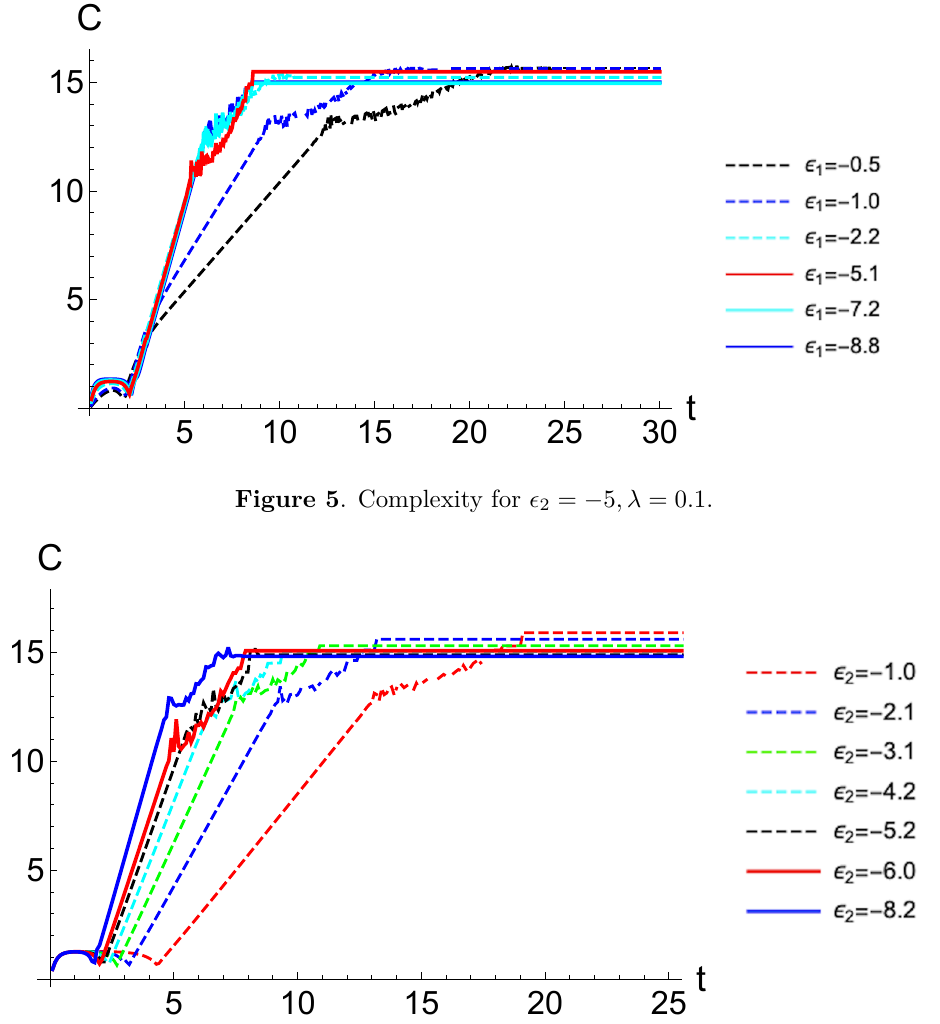
Figure 6 . Complexity with fixed (cid:15) 1 = − 6 , λ = 0 . 1